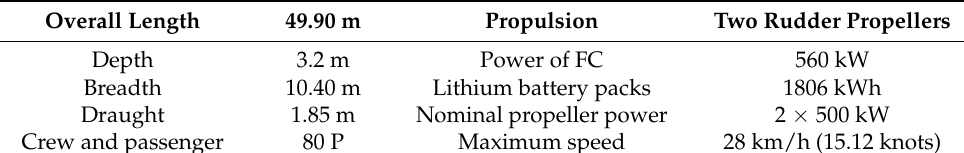
Table 1. General arrangement of “San Xia Qing Zhou 1”.